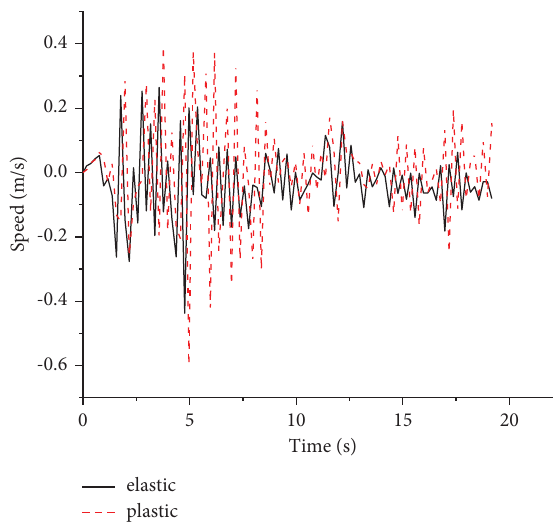
Figure 12: Time - history curve of speed in the second span.